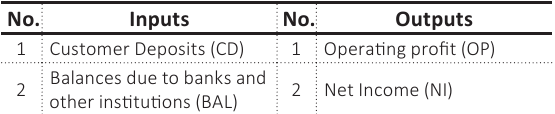
Table 2. List of input and output variables